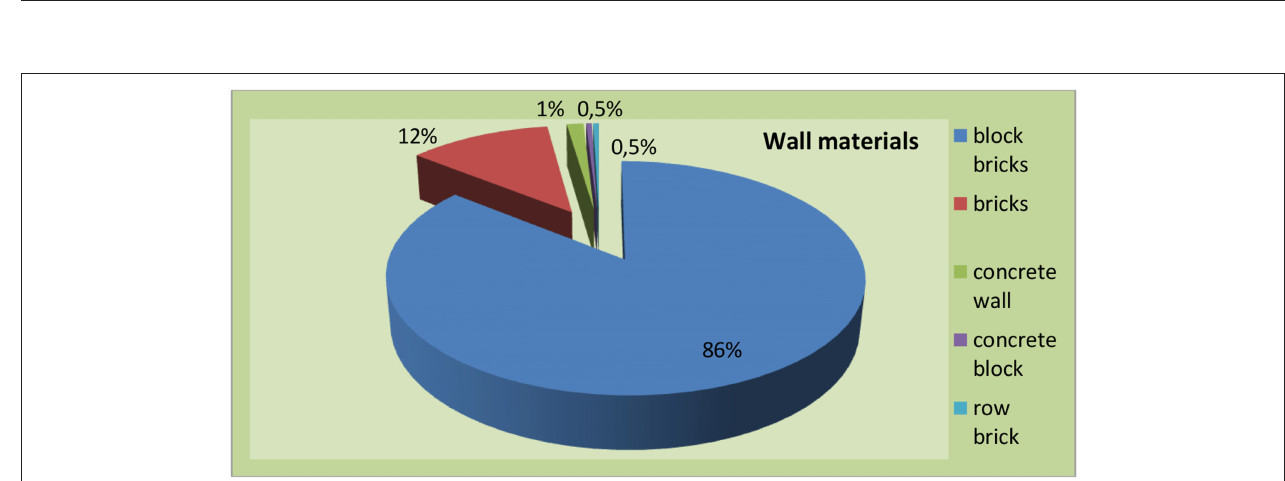
FIGURE 6 | Wall materials of buildings in the database.